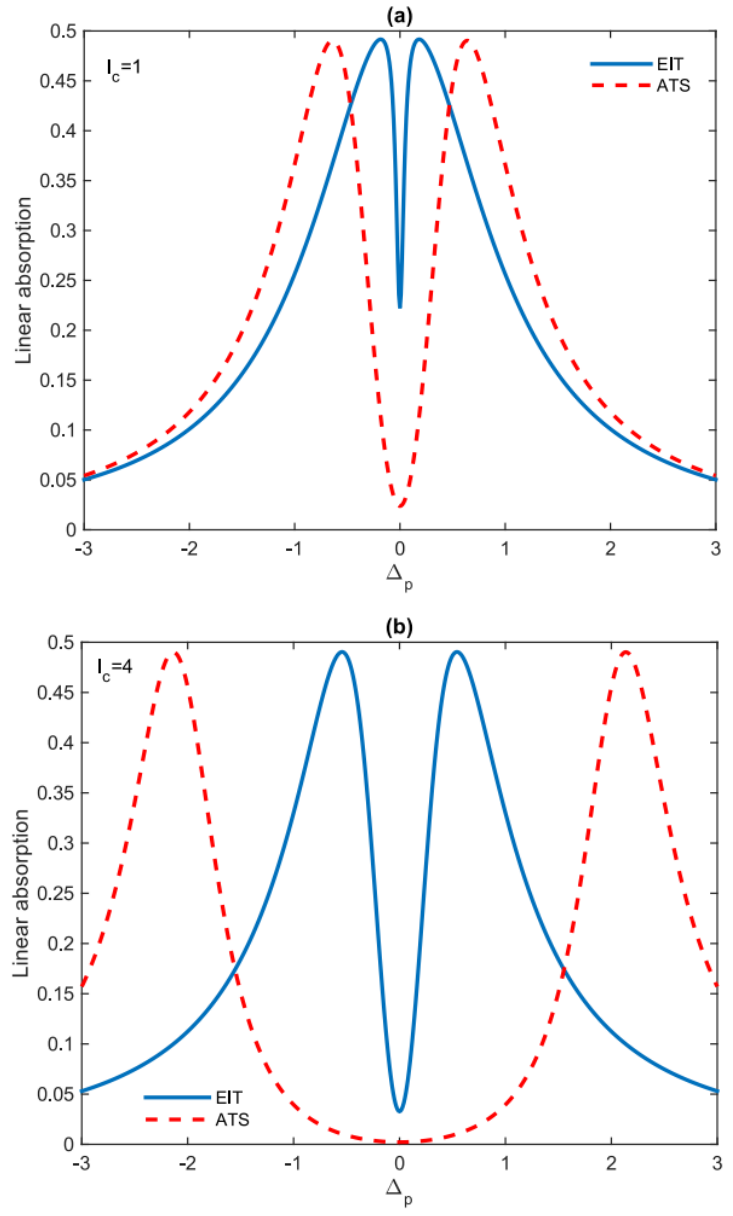
( 1 ) Im( ) σ vs. probe detuning when the coupling light ) vs. probe detuning when the coupling light Figure 4. Linear absorption of the FWM light Im ( σ Figure 4. Linear absorption of the FWM light (1) 30 30 carries an optical vortex ( a ) l c = 1 and ( b ) l c = 4. The solid line corresponds to EIT ( ε c = 0.98 γ 30 ) and l 1 = and ( b ) l 4 = . The solid line corresponds to EIT ( 0.98 ε γ = ) and carries an optical vortex ( a ) c c c 30 dashed line corresponds to ATS ( ε c = 4 γ 30 ). The selected parameters are r/w = 1.5, γ 20 = 0.02 γ 30 . 4 ε γ = ). The selected parameters are r / w 1.5, 0.02 γ γ = = . dashed line corresponds to ATS ( c 30 20 30 Identifying the intensity limits for the creation of EIT and ATS, in Figure 5 we display the FWM conversion efficiency in three different regimes: joint EIT-ATS, dual ATS,